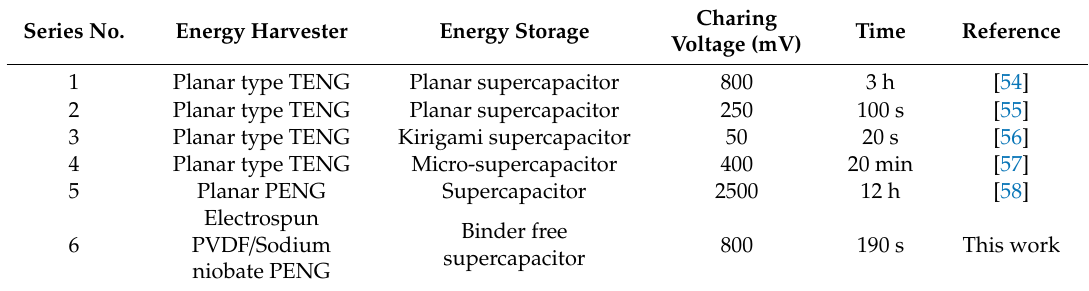
Table 2. Comparison of the self-powered supercapacitor performances using triboelectric nanogenerator (TENG) and piezoelectric nanogenerator (PENG). Series No.